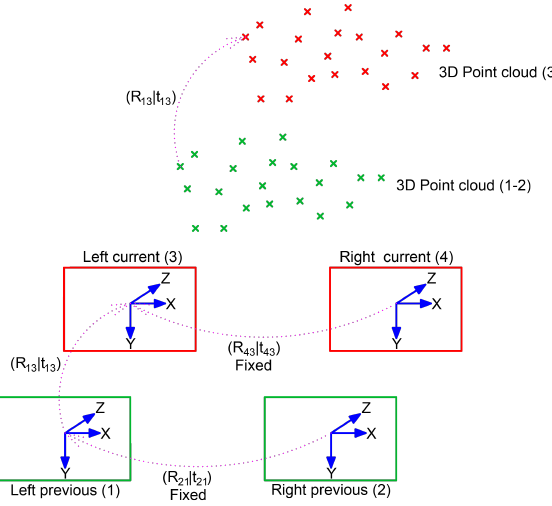
Figure 8. Image quadruplet, current (left and right) and previous (left and right) frames are used to compute two 3D point clouds.